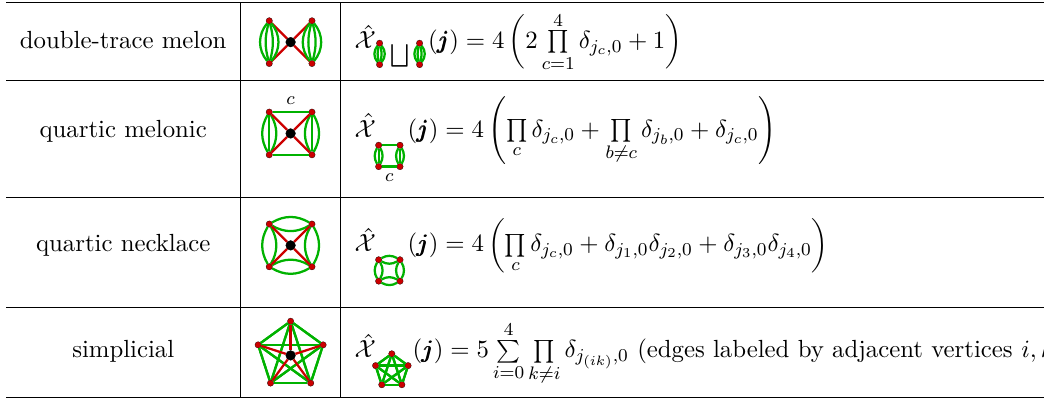
Table 1 . Examples of non-local interaction vertex graphs for r = 4 group arguments and the resulting operator ˆ X γ in representation